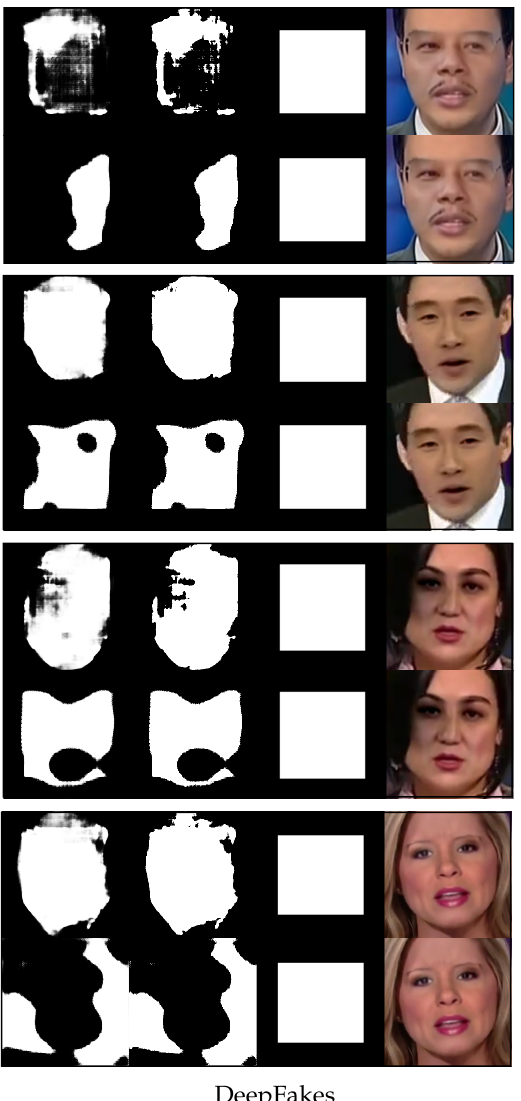
Figure 4. Four rows of randomly selected images from DeepFakes and their predicted results for the fake region with one-shot fine-tuning. The top sub-row of each row is the result generated by the proposed method, and the bottom sub-row of each row is the result without using the proposed method. In each sub-row, from right to left, there is the image altered by DeepFakes , the ground truth of the altered region (mask), the binary predicted output, and the gray-scale predicted output. The results are performed with K = 1 shot